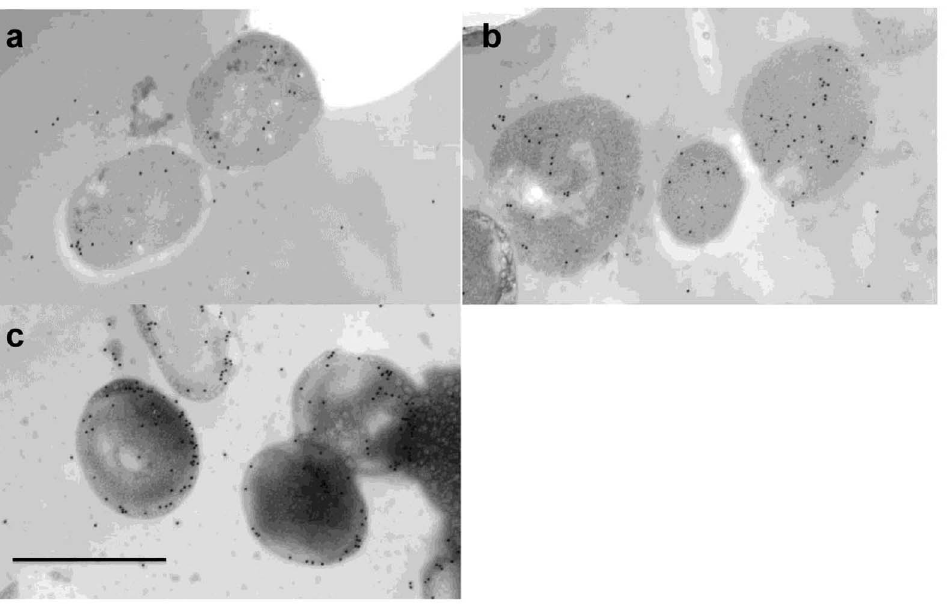
stationary growth phases, are shown in (a), (b) and (c), respectively. Bar, 1 m m.